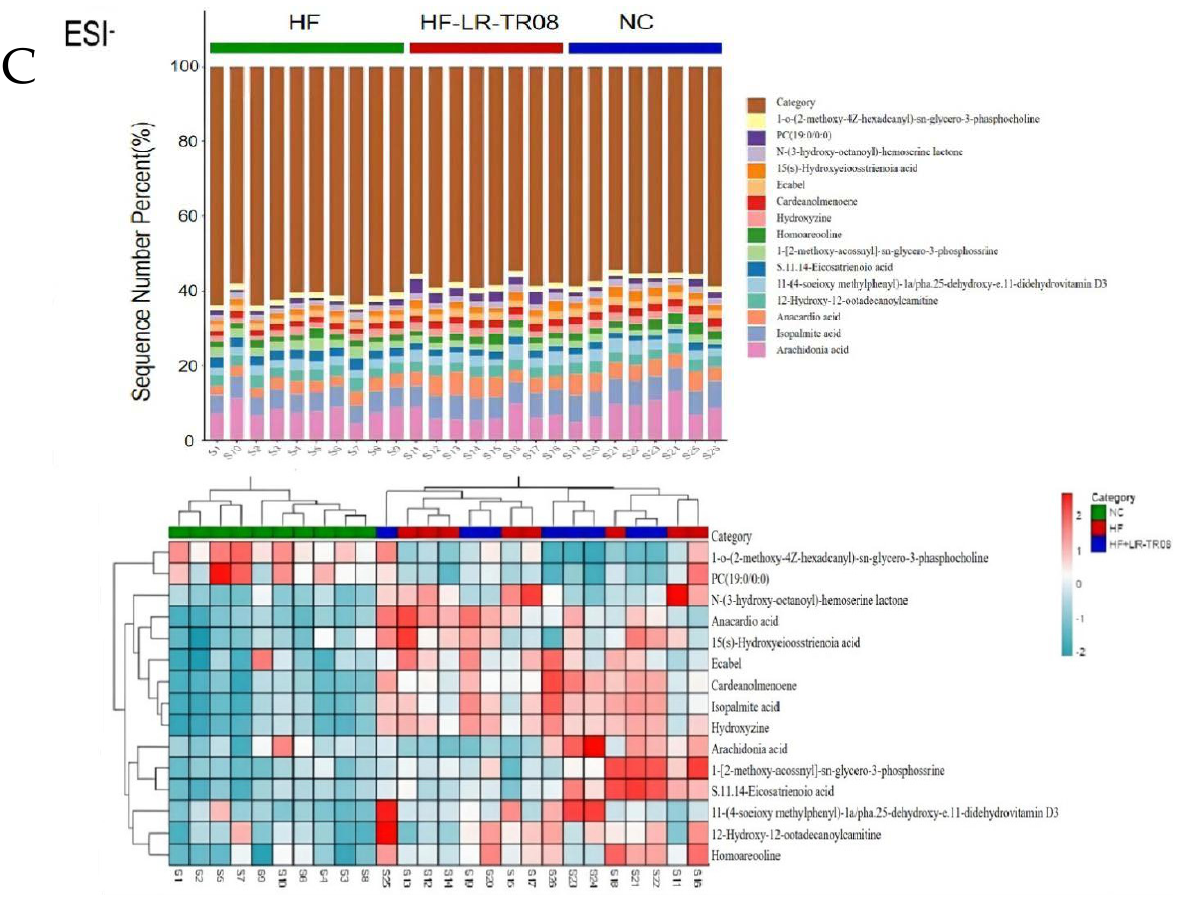
Figure 5. Results of PCA and OPLS − DA ( A ), cluster heat map ESI+ ( B ), and cluster heat map ESI+ ( C ) analysis of metabolites in mouse plasma. Table 1. The differential metabolites between the high − fat diet and high − fat diet + L. rhamnosus TR08 strain groups.